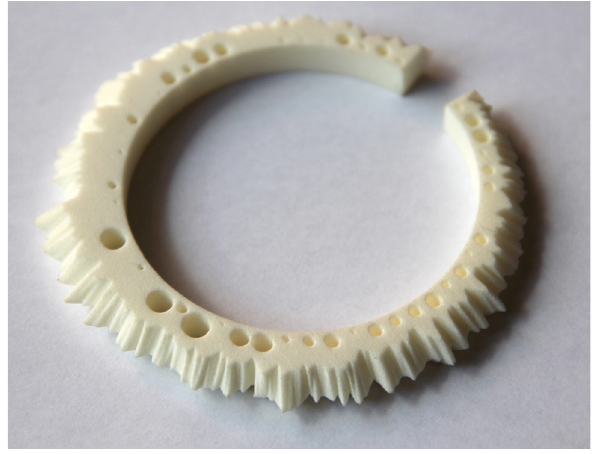
Figure 10 | Weather Bracelet, Whitelaw, 2009.